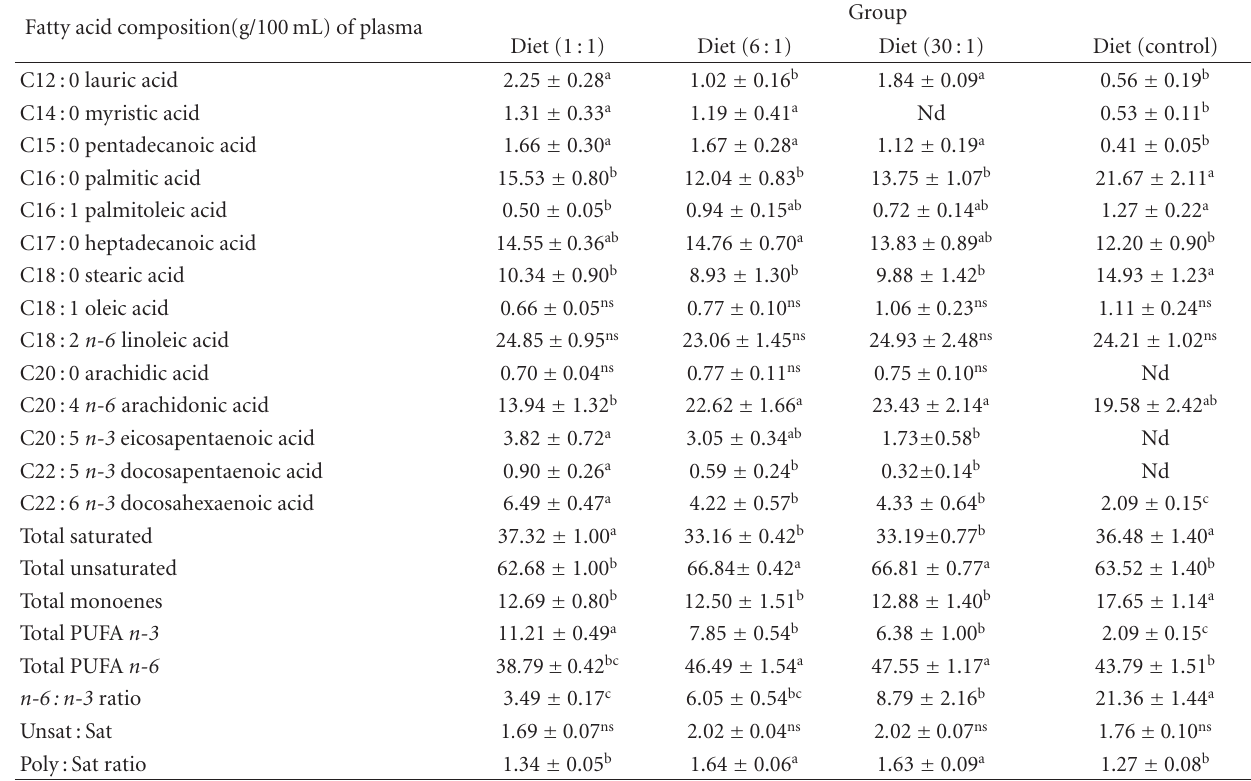
Table 2: Plasma fatty acid composition (mg/100 mL; Mean ± SE; n = 7) of rats from di ff erent treatment groups after 10 weeks of feeding. Fatty acid composition(g/100mL) of